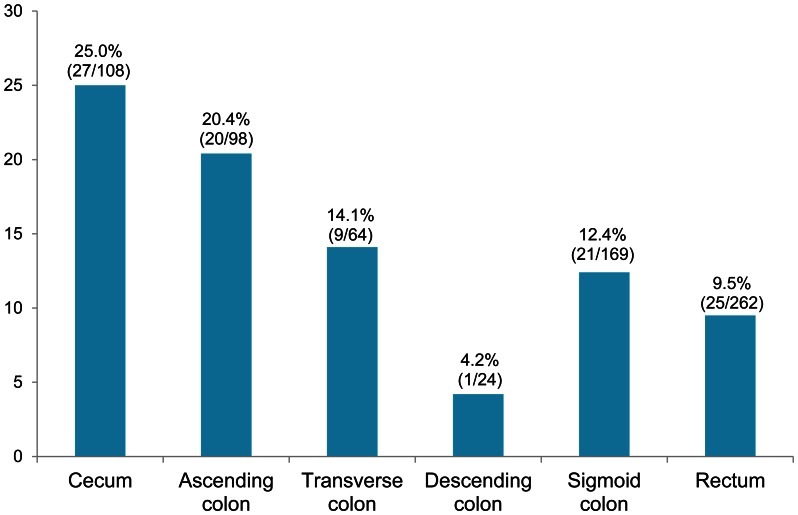
Proportion of PIK3CA mutation in colorectal carcinomas from each segment of the large bowel.